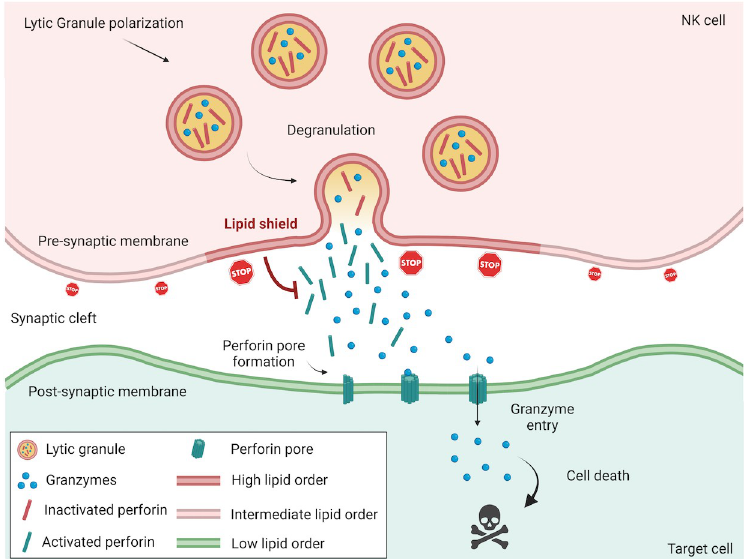
Fig 1. NK cells assemble a perforin-resistant lipid shield at the immunological synapse. During directional killing of virus-infected and transformed cells, NK cells establish an immunological synapse to which lytic granules are recruited before they fuse with the presynaptic membrane and release their cytotoxic content, including perforin and death-inducing granzymes, into the synaptic cleft. While perforin is inactive inside lytic granules (due to low pH and calcium concentration), it becomes fully operational in the extracellular environment where it oligomerizes in a calcium-dependent manner and creates pores into the target cell membrane. D AU : PleasecheckwhethertheeditstothesentenceDuringtargetcellengagement ; NKcellsrapidlyassemble ::: arecorrect ; andprovidecorrectwordingifnecessary : uring target cell engagement, NK cells rapidly assemble a highly lipid-ordered presynaptic membrane, resulting from lipid raft aggregation that potently inhibits perforin membrane binding. Moreover, upon fusion with the NK cell plasma membrane, lytic granules, which have an intrinsically highly ordered membrane, further increase lipid packing density at the degranulation sites and thereby confer an additional layer of protection where the concentration of secreted perforin presumably peaks. N AU : AnabbreviationlisthasbeencompiledforthoseusedthroughoutFig 1 : Pleaseverifythattheentryiscorrect : K, natural